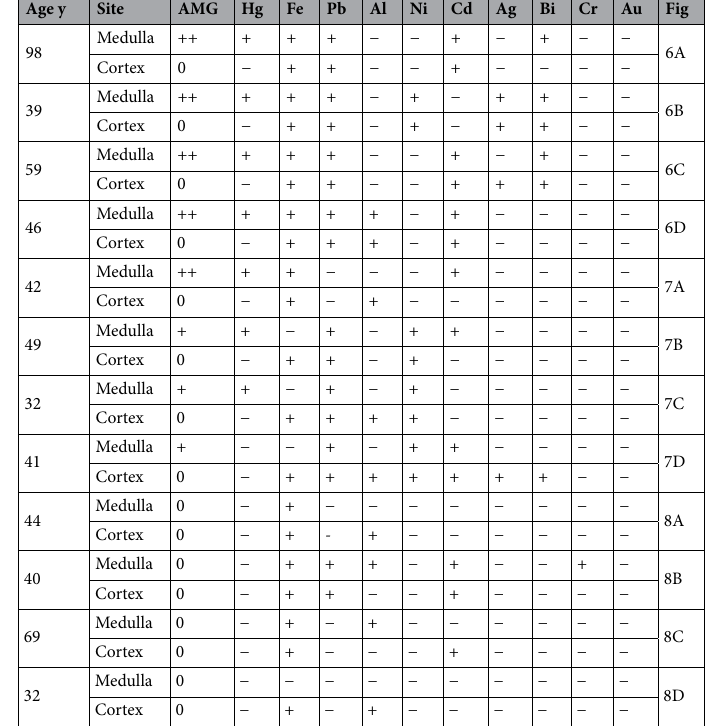
Table 1. Potentially toxic metals found by LA-ICP-MS and AMG in 12 human adrenal glands. AMG: 0 none,+low, ++ high. LA-ICP-MS metals: − not detected,+detected. Fig: figure. Gold (Au) LA-ICP-MS results (all negative) are not shown in Figs. 6, 7 and